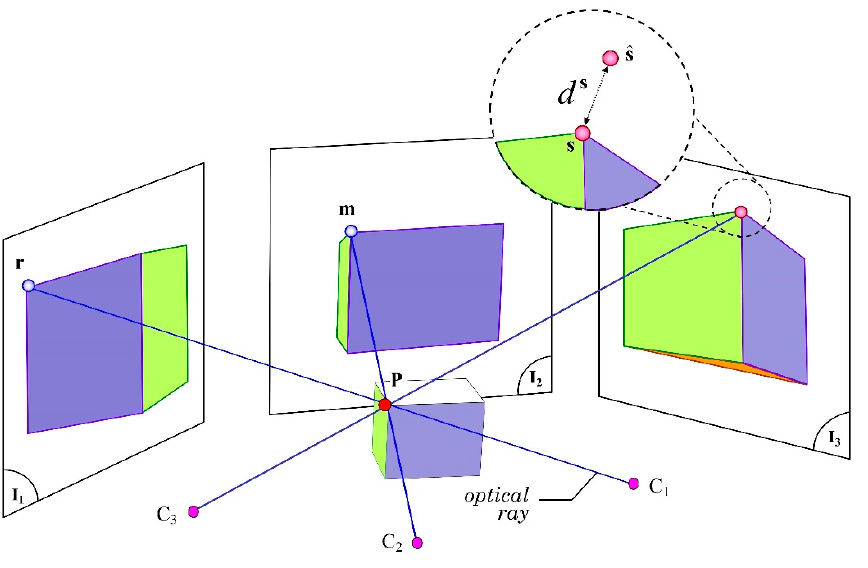
Figure 3. Three view-based epipolar geometry of an object in the 3D